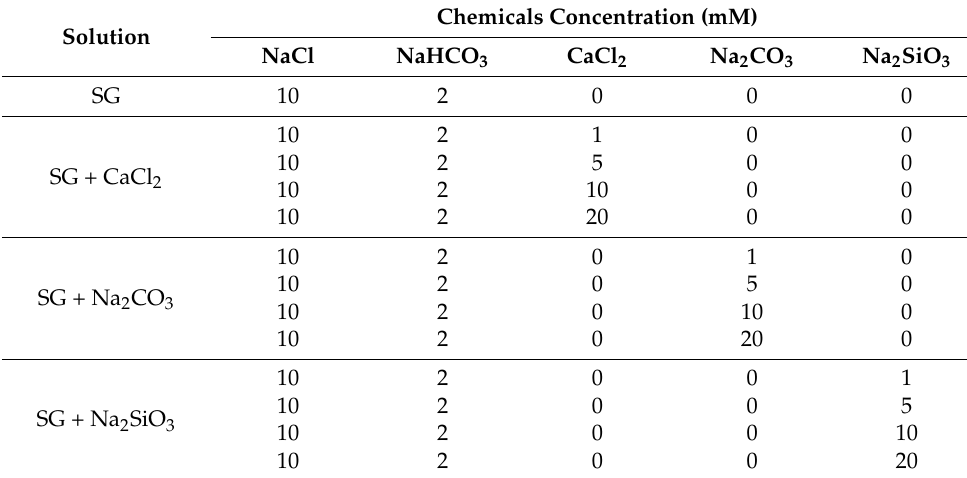
Table 2. Chemical composition of simulated groundwater.